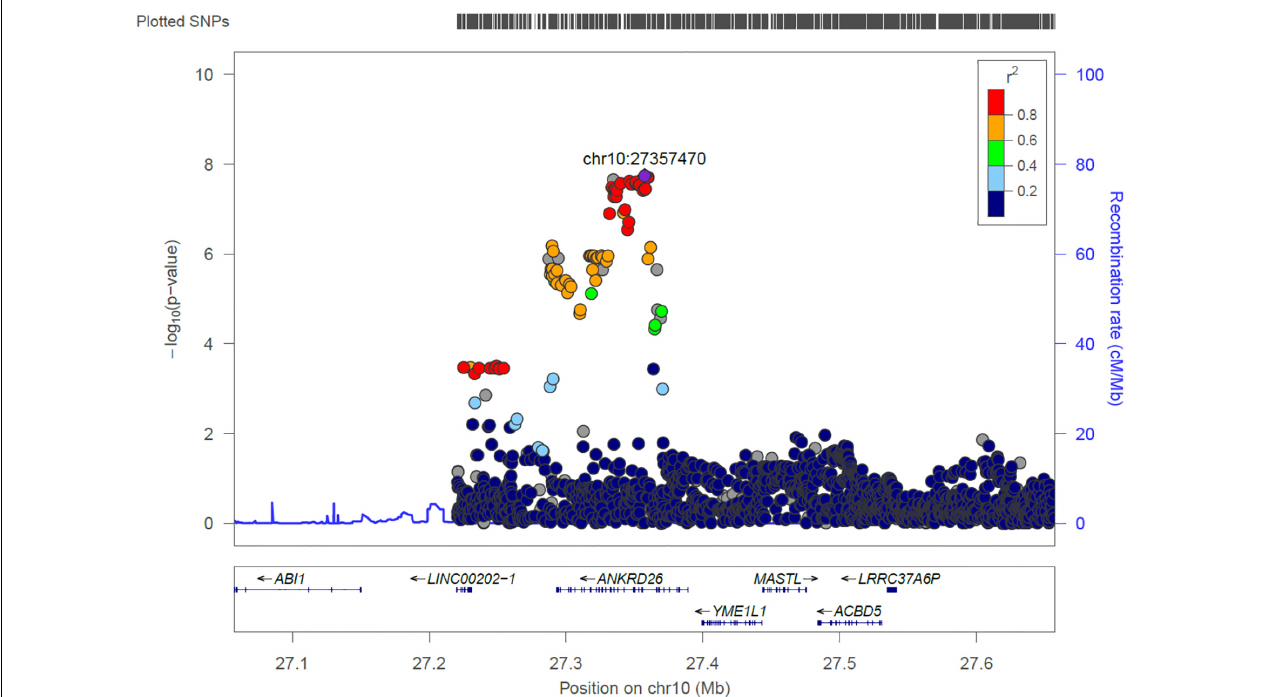
FIGURE 7 | Regional visualization of the GWAS of –log10 of the P -value of genomic location ANKRD26 (rs112505971 in purple), with each dot representing a SNP on the corresponding genes at the bottom.